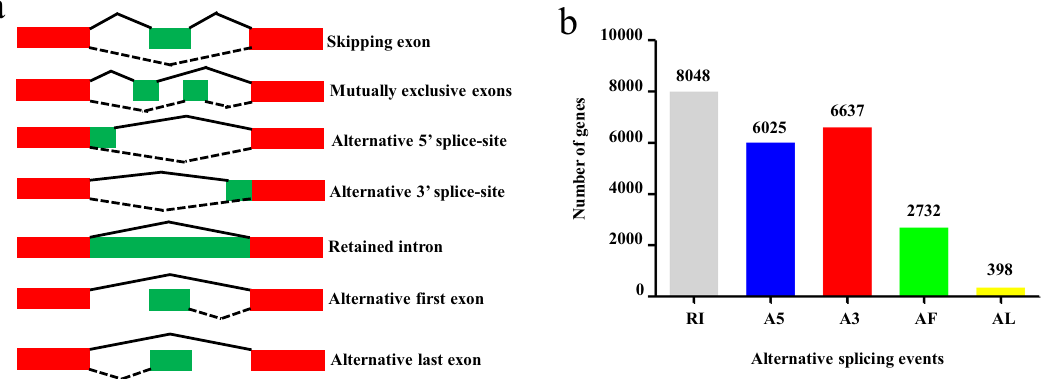
Figure 3. Alternative splicing (AS) with different models. ( a ) Seven types of AS. ( b ) The number of AS events occurred in detected genes from SMRT sequencing. The figures were constructed in Microsoft Office PowerPoint and Excel.